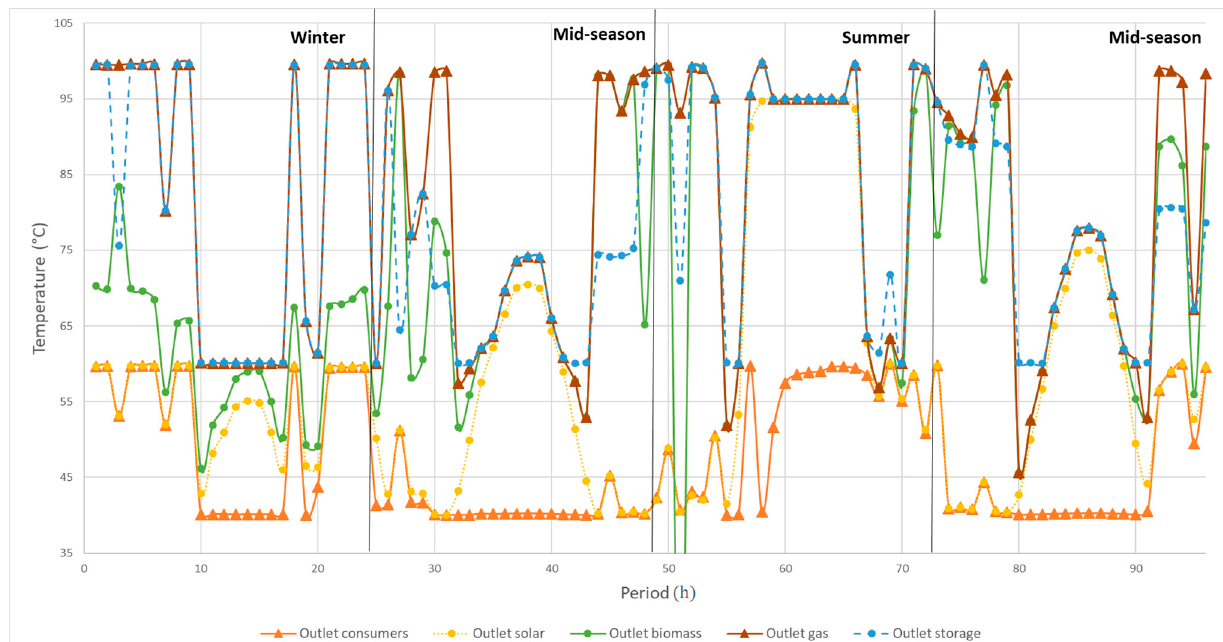
Figure 13. Temperature at different points of the DHN (connection 3).